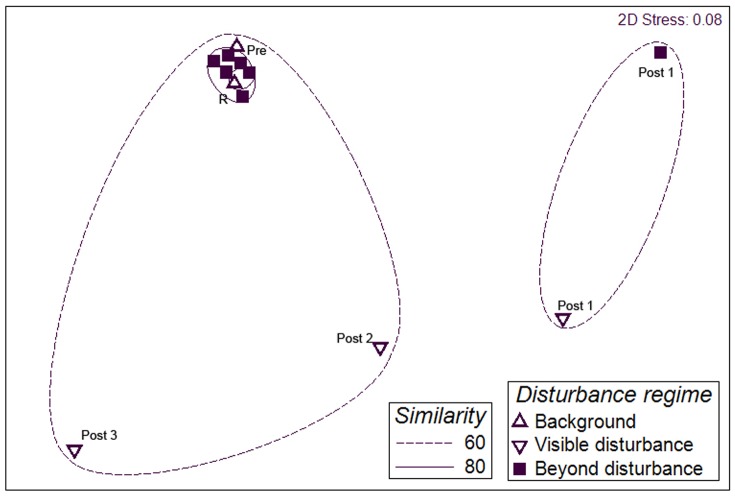
Multidimensional scaling ordination of megafaunal assemblages under different disturbance conditions.Based on Bray Curtis similarity of pooled invertebrate megafaunal density data for the disturbance zones in 2006 (Pre, Post 1 and Post 2) and 2009 (Post 3, R). For each survey the transects have been divided into Background, Visible Disturbance and Beyond Disturbance according to the coverage of the sediment by drill cuttings, notable groups are labelled. Similarity levels from cluster analysis.